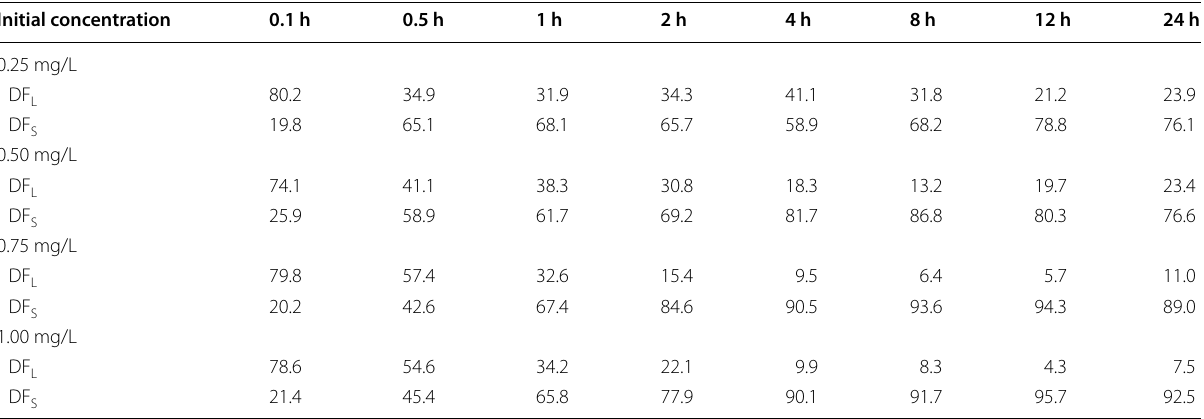
Table 3 DF of As in liquid phase and solid phase (%) Initial